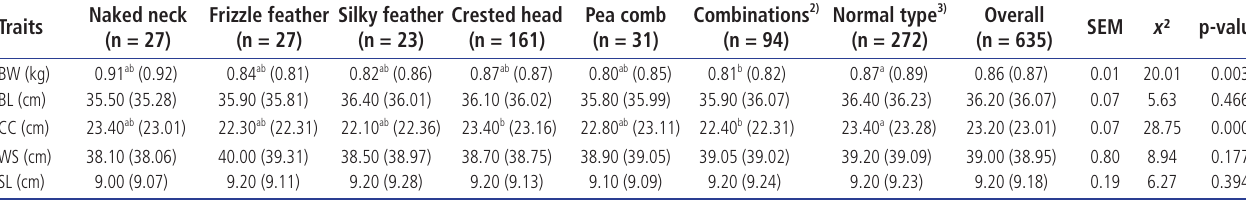
Table 3. Medians (means in parentheses) of morphometric traits measured in female local chicken phenotypes 1)